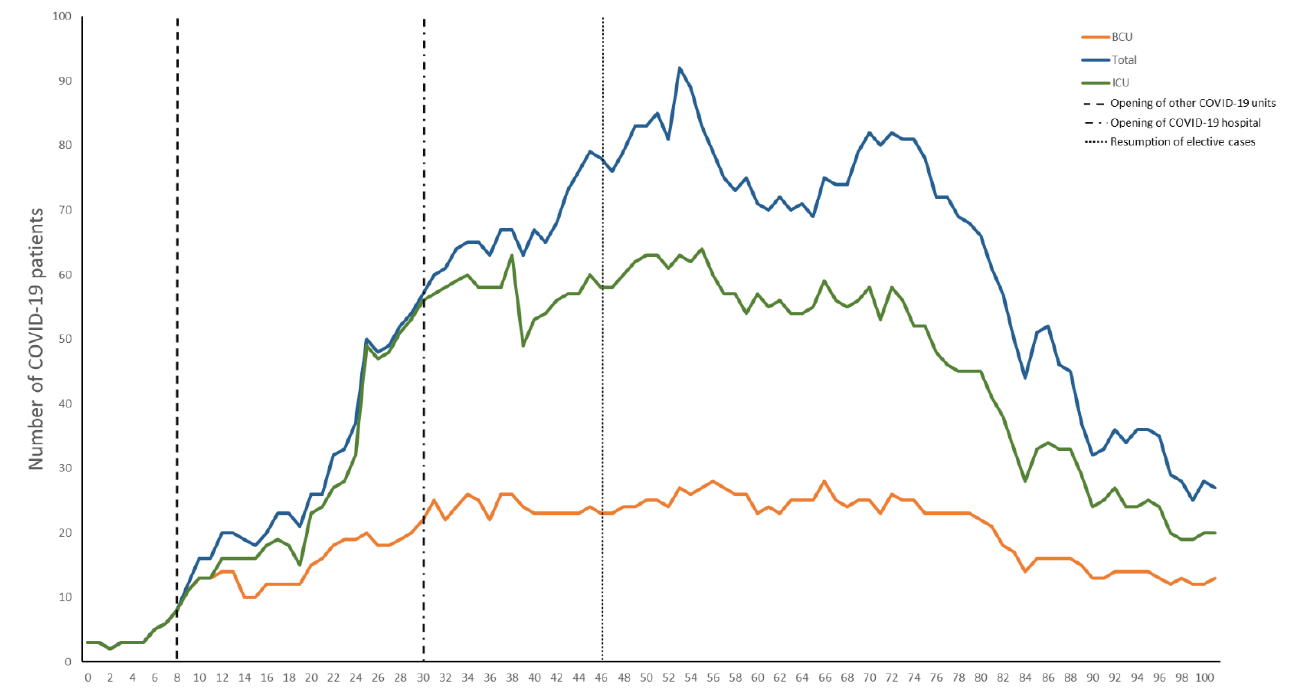
Figure 2. Positive patients admitted to our institution. Day 0 is when the first COVID-19 patient was placed on extracorporeal membrane oxygenation (ECMO). Legend: BCU—biocontainment unit, ECMO—extracorporeal membrane oxygenation, ICU—intensive care unit.